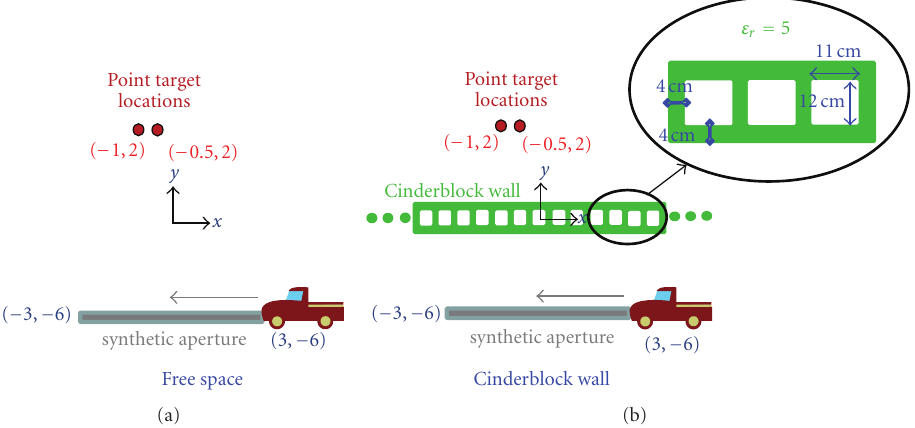
Figure 2: Illustration of the near zone through-wall sensing: (a) in the absence of a wall, (b) in the presence of a periodic cinderblock wall.